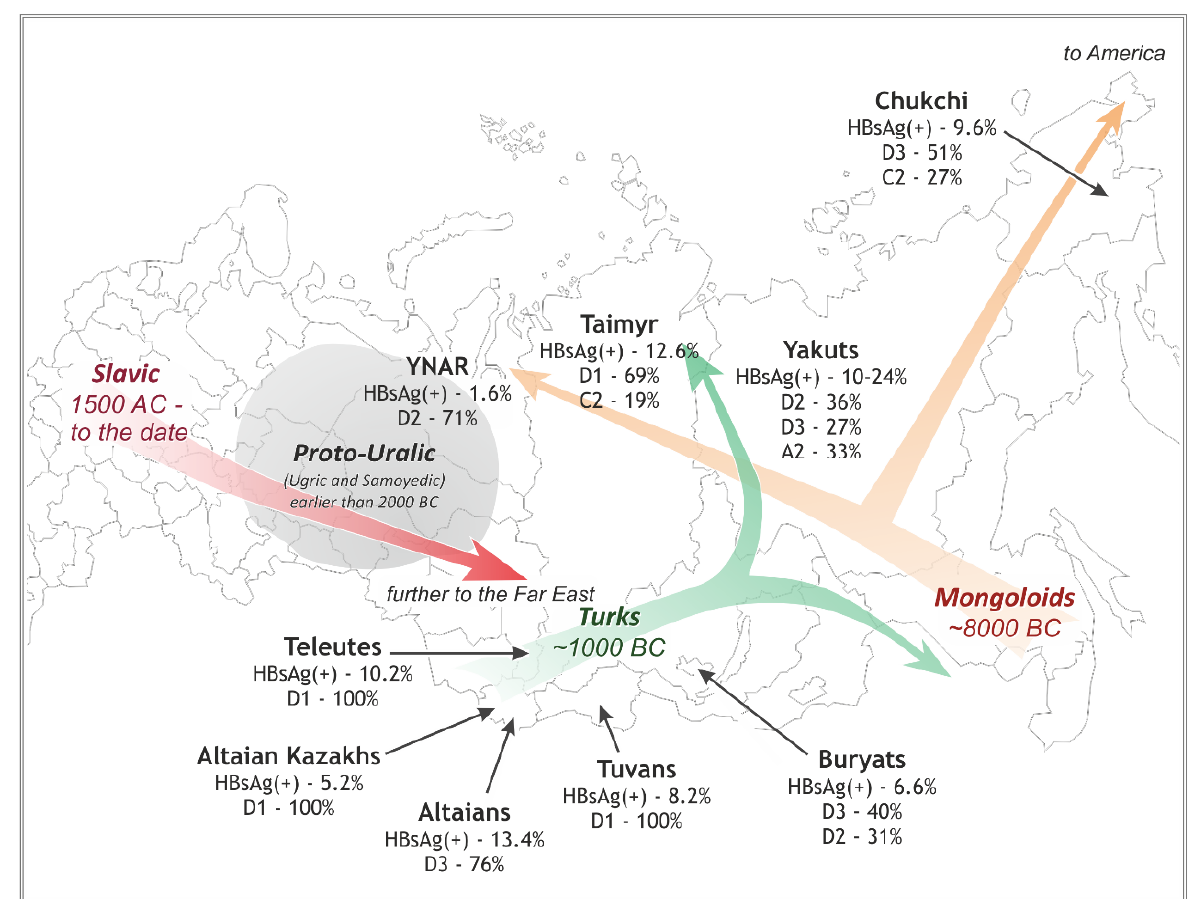
Figure 1. A schematic map showing the locations of the studied native Siberian populations. The prevalent HBV subgenotypes in these populations are shown along with reported HBsAg incidence (detailed data are in Table 2). The colored arrows designate the main migration pathways during the settlement of Siberia in the past ten millennia (see Section 4).